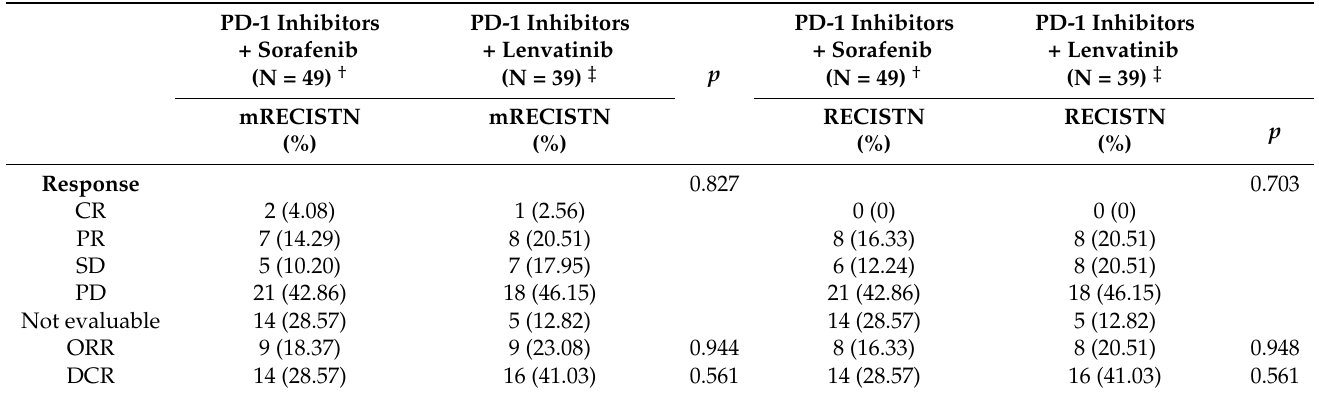
Table 2. Treatment response between patients treated with immune checkpoint inhibitors combined with multitarget tyrosine kinase